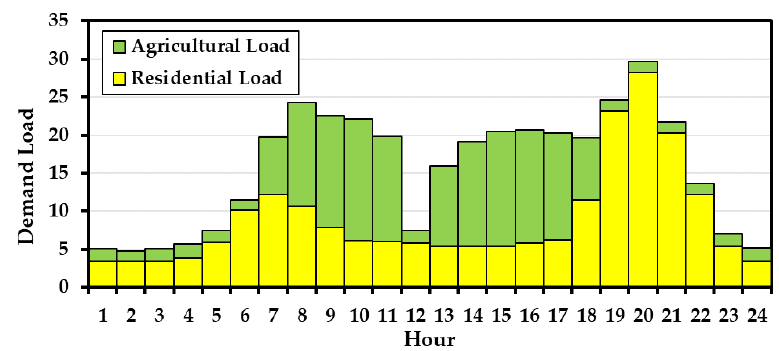
Figure 6. Estimated hourly combined residential and agricultural load demand of the study area based on household